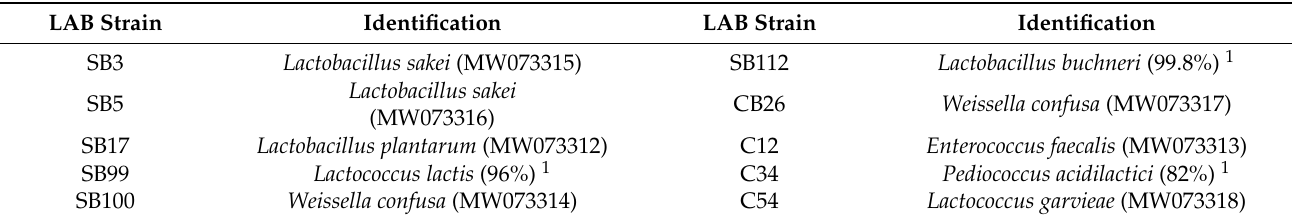
Table 1. Identification of the native LAB isolates